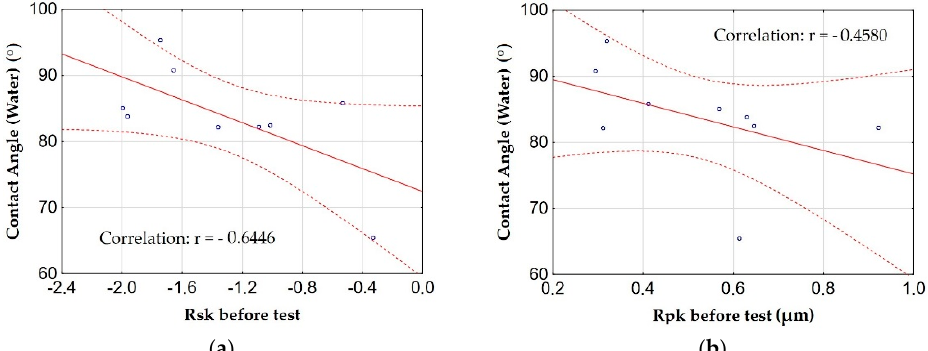
Figure 17. The relationship between the contact angle measured by water and: ( a ) the Rsk parameter, ( b ) the Rpk parameter.